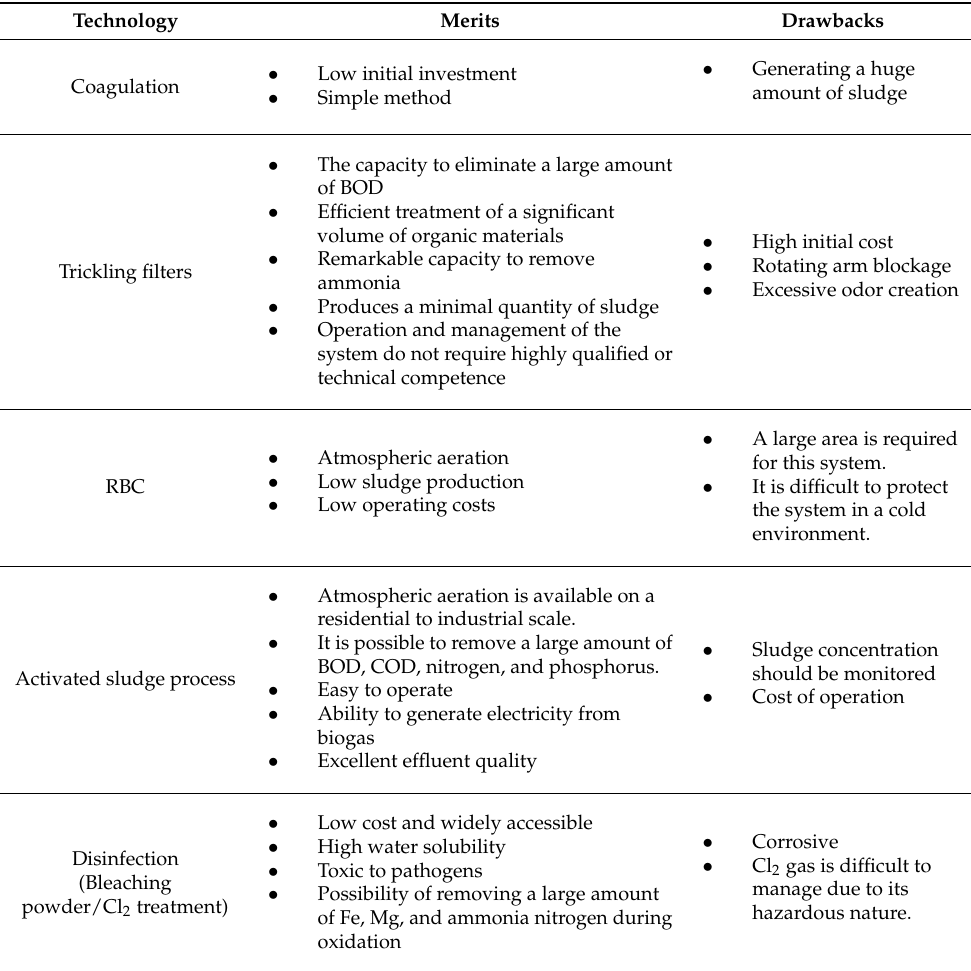
Table 1. Different wastewater treatment processes’ merits and